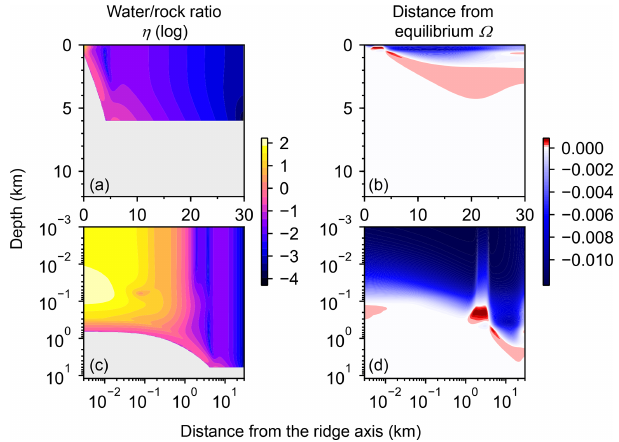
Figure 5. Two-dimensional distributions of local water / rock oxy- gen mole ratio ( a and c ) and degree of oxygen isotope exchange at a seawater δ 18 O value of 0‰ ( b and d ). The same data in (a) and (b) are plotted on logarithmic scales in (c) and (d) , respectively. See the caption of Fig. 1 for the explanation of gray zones in (a) and (c) .